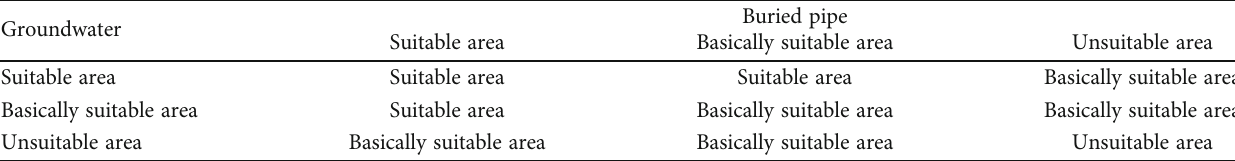
Figure 10: Suitability zoning map of the buried pipe ground source heat pump. Table 8: Comprehensive suitability classi fi cation table of the ground source heat pump